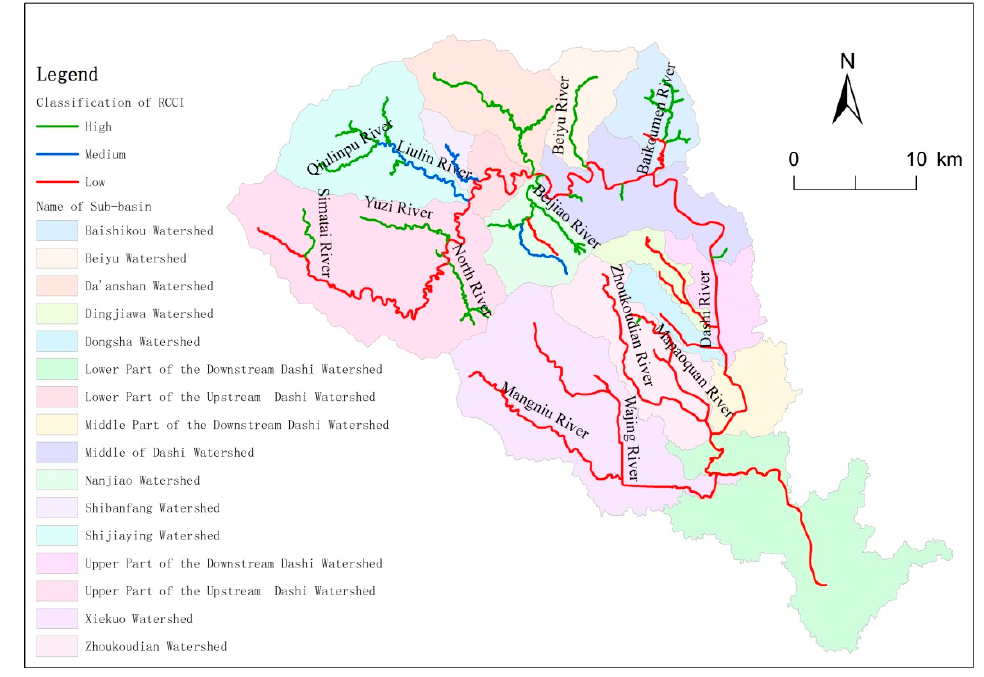
Figure 6. RCCI assessment result for each tributary.